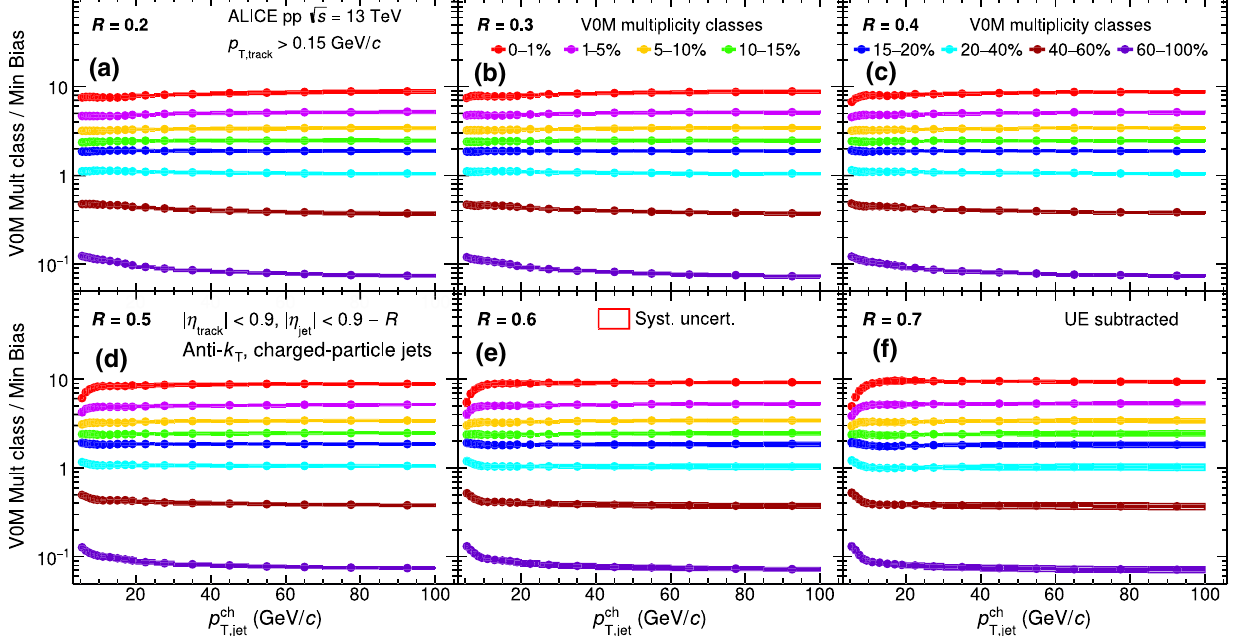
Fig. 8 Ratio of charged-particle jet yield measured in different multiplicity classes with respect to that in MB events as a function of p T for different resolution parameters R from 0 . 2 to 0 . 7. Statistical and total systematic uncertainties are shown as vertical error bars and boxes around the data points,